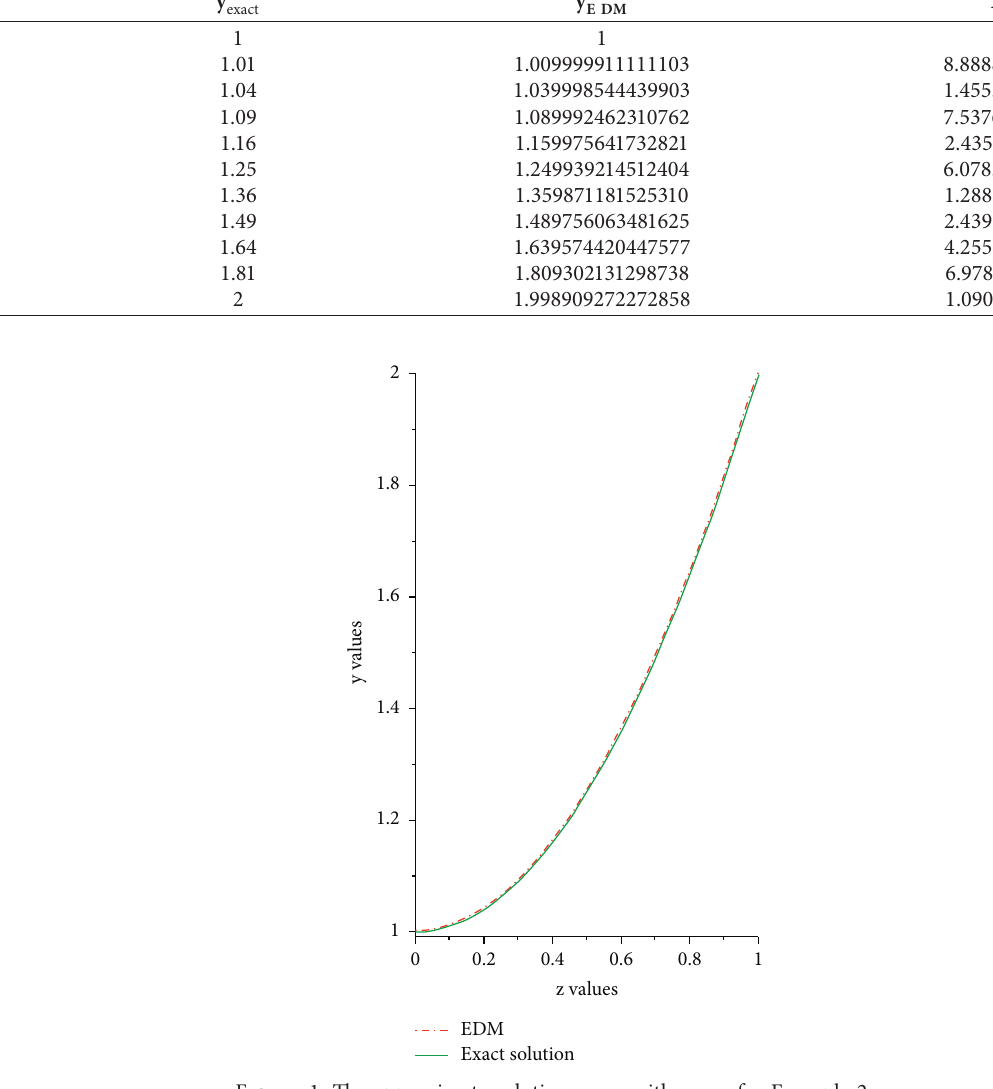
with y for Example EDM exact